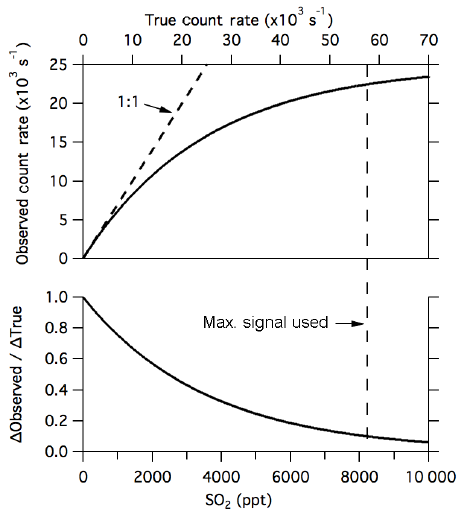
Figure 5. Count rate linearity adjustment. (Top) Calculated rela- tionship between observed and true photon count rates from Eq. (1) assuming a 25kHz laser pulse frequency and a maximum of 1 count/laser pulse. (Bottom) Fraction of increased signal observed as a function of the true count rate. Bottom axis shows the SO 2 mixing ratio assuming 300 =CPS background and 7CPSppt − 1 SO 2 .